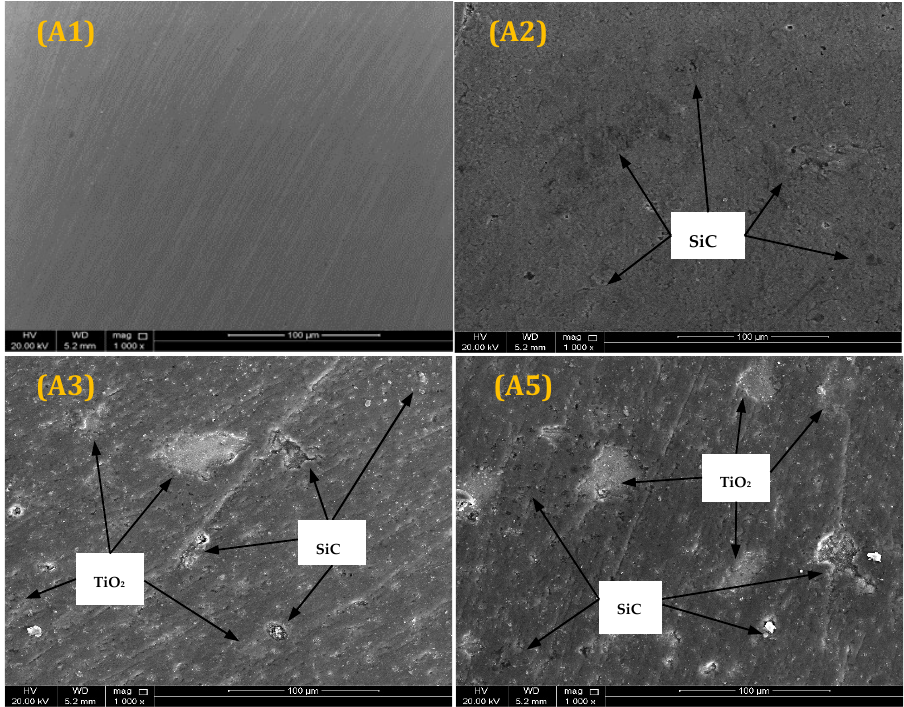
Figure 4. SEM micrographs of the ( A1 ) pure Al, ( A2 ) Al/5SiC, ( A3 ) Al/5SiC/3TiO 2 , and ( A5 ) Al/5SiC/9TiO 2 hybrid nanocomposites.